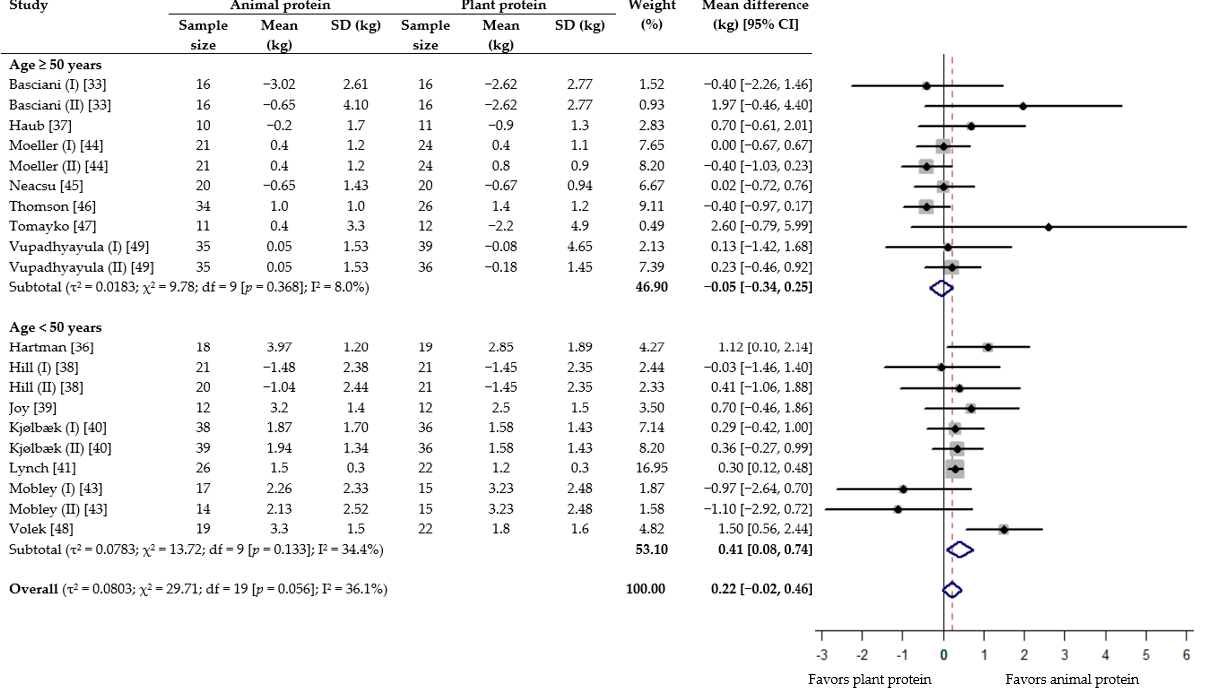
Figure 2. Effect of consuming animal protein compared to plant protein on changes in absolute lean mass (kg) based on age group. Data expressed as weighted mean differences with 95% CIs, using a random ‐ effects model.